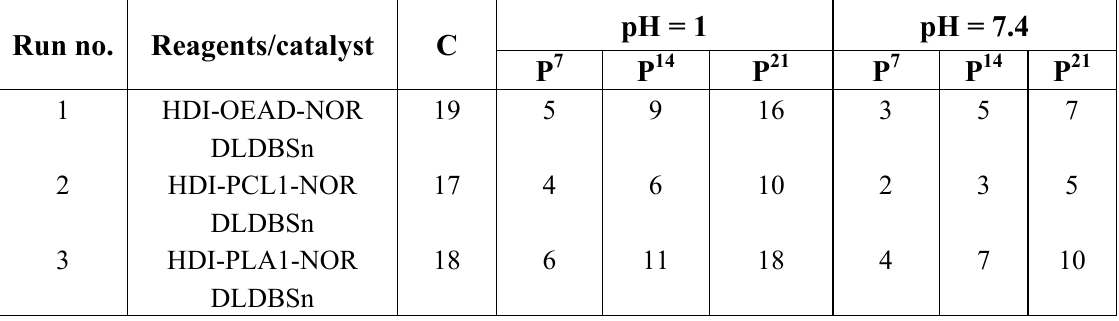
Table 3. Release of the norfloxacin from polyurethane